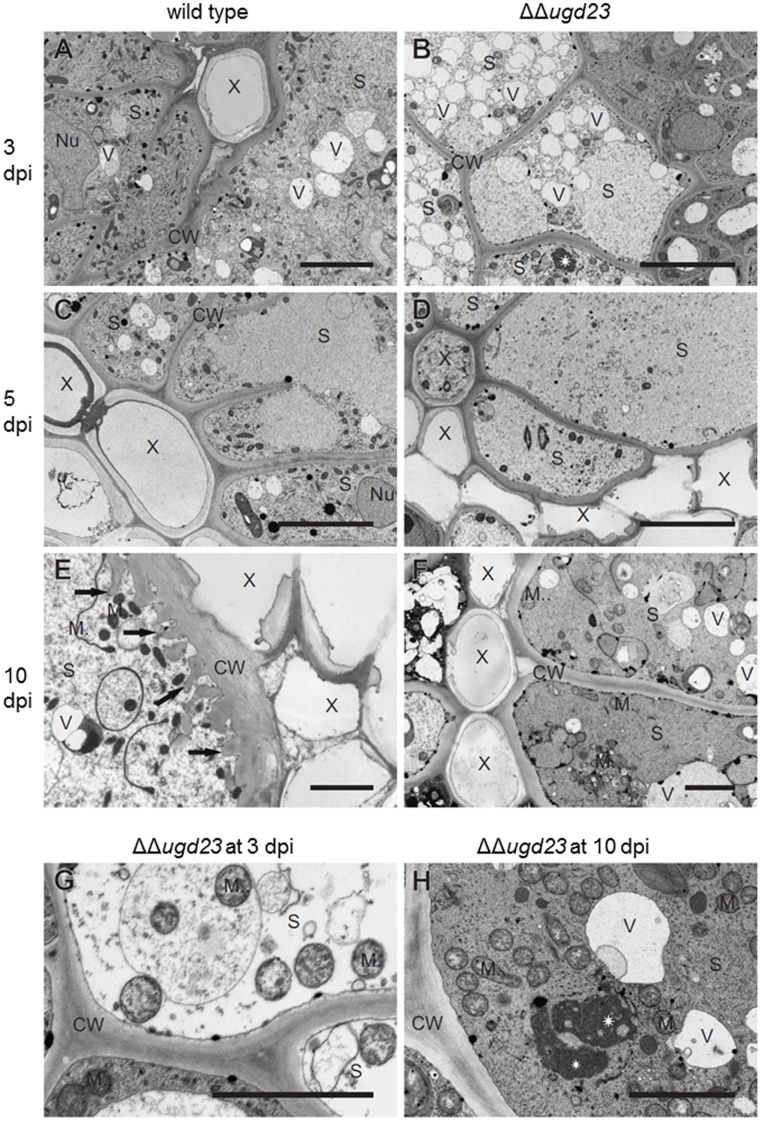
Electron microscope comparison of syncytia developed in wild type andΔΔugd23
 mutant roots. Syncytia induced in ΔΔugd23 mutant roots at 3 dpi lacked electron dense cytoplasm and numerous organelles are degenerated compared to those induced in wild-type roots. 5 dpi syncytia in ΔΔugd23 mutant revealed a similar ultrastructure as observed in 3 dpi syncytia. 10 dpi syncytia associated with a female nematode in roots of ΔΔugd23 mutants lacked cell wall ingrowths compared to wild type syncytia. Sections of syncytia induced in wild type (A, C, and E) and ΔΔugd23 (B, D, and F–H) plants collected at 3 (A, B and G), 5 (C and D) and 10 (E, F, and H) dpi. Scale bars 5 (A–D) and 2 (E–H) µm. CW: cell wall, M: mitochondrion, N: nucleus, S: syncytium, X: xylem, V: vacuole, arrows: cell wall ingrowths (E). Asterisk: chromatin/nucleolus clumps (B and H).